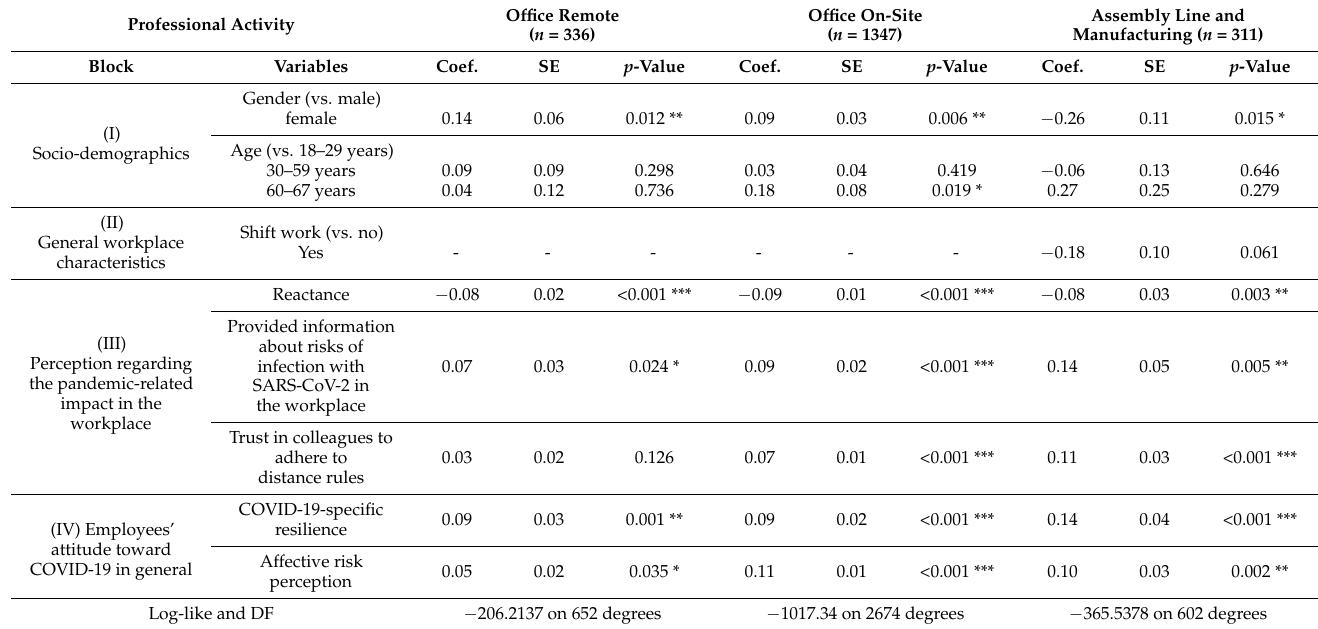
Table 2. Attitude toward technical OSH-measures for infection